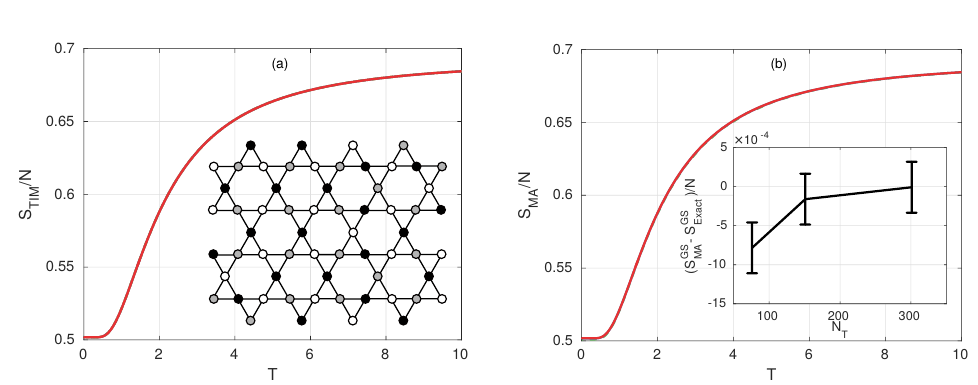
Figure 1. (a) Entropy density obtained by the TIM method, for L = 16, 32, 68, 76, 84 with N T = 301. The lines for di ff erent L coincide (the error bars are not shown because they are smaller than the line widths). The inset shows the Kagome lattice composed of three interpenetrating sublattices (di ff erent shades). (b) Entropy density for L = 32 and N T = 76, 151, 301. Lines for di ff erent N T are almost identical. The inset shows the di ff erence between the ground state entropy density calculated using TIM and the exact